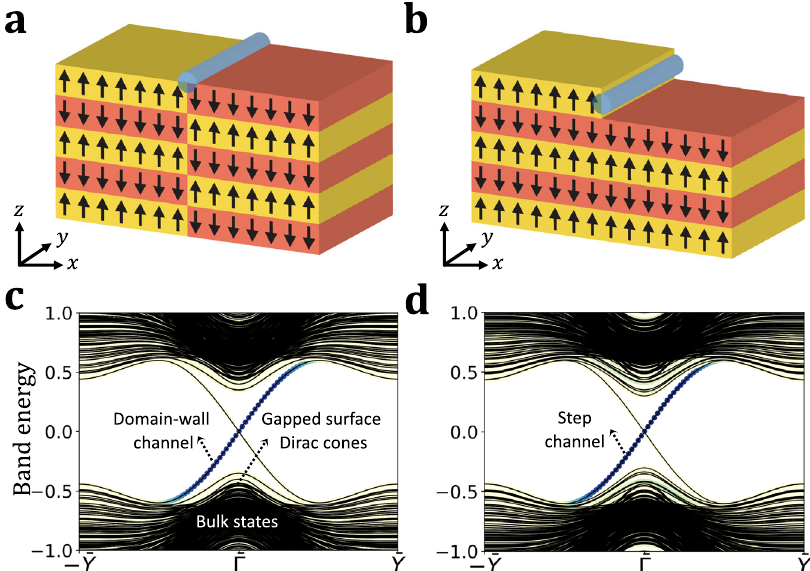
Fig. 1 Types of chiral channels at surface of an A-type antiferromagnetic topological insulator (AFM TI). Depiction of the chiral channel (blue cylinder) due to ( a ), a bulk domain wall ( b ), a surface step. Surface band structures along (001) in the presence of ( c ), a bulk domain wall ( d ), a surface step. The projection of the states on the chiral channels (blue cylinder) in ( a ), ( b ), are also shown (blue markers) to illustrate the localization of the massless Dirac fermions that disperse linearly along the channel direction at low energy with velocities ( c ), v dw and ( d ), v st . The description of the model Hamiltonian can be found in “ Methods ” . Energies are expressed in terms of the onsite energy m in Eq. (8).